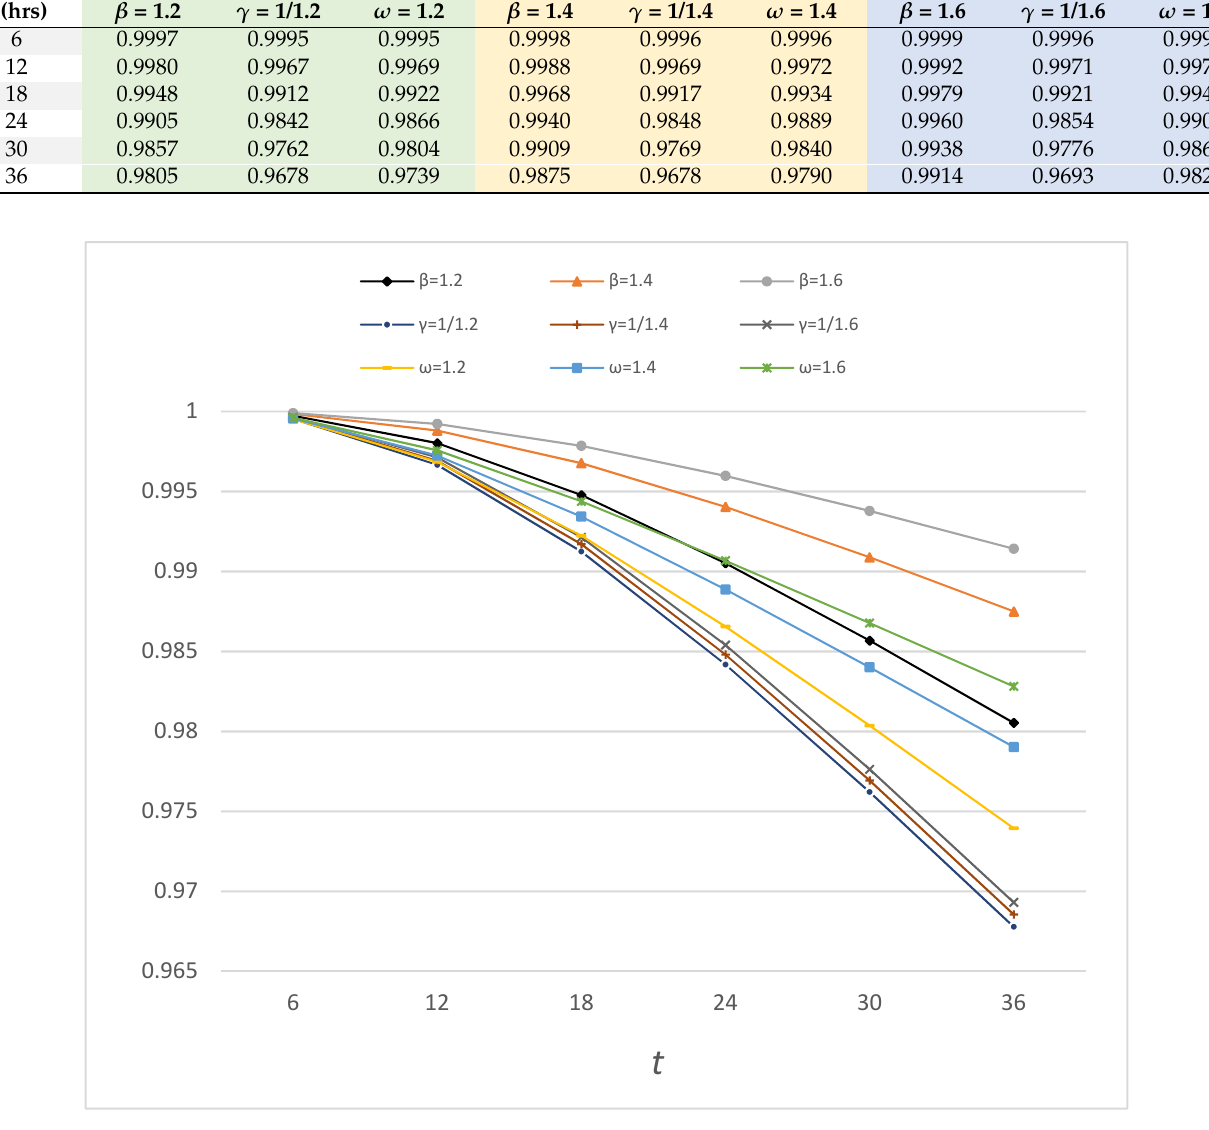
Figure 8. Bitcoin dependability under the DDAA, ALP, and TM.